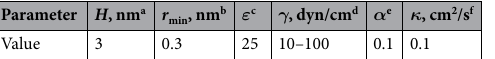
Table 1. Some parameters related to FIN. a Following published estimates 8–10 . b We use r min discussed in the early work on FIN 5 . c We use the dielectric permittivity of HfO 2 . d Because the values of interfacial energies in materials undergoing FIN are not available, we use the ballpark of typical values for a variety of other systems 44,45 . e See the discussion after Eq. (1). f Thermal diffusivity estimated or HfO 2 based RRAM devices 6